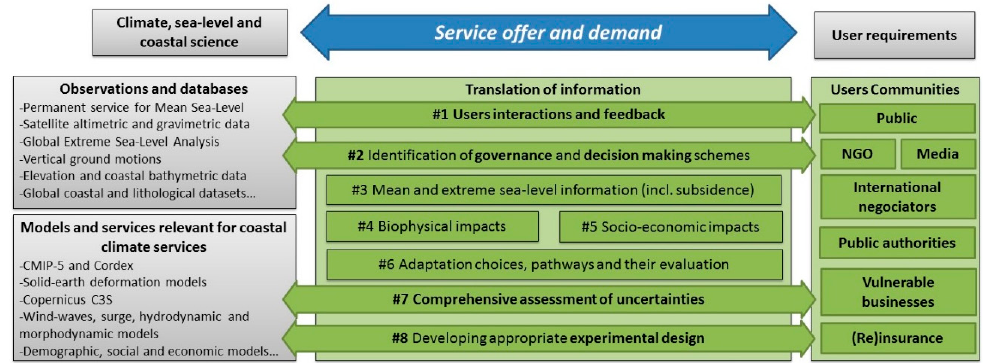
Figure 6. A framework for developing CCS (after: Monfray and Bley, 2016 [105]). This framework is valid as long as CCS based on sea level scenarios or projections are in a phase of research and development (Table 3).